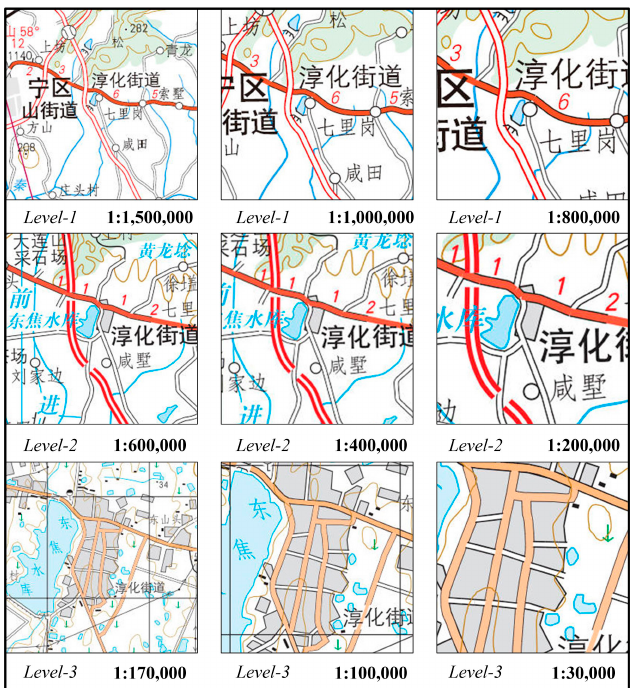
Figure 15. Multi-level PDF tile adaptive zooming. All ratios from “1:1,500,000” to “1:30,000” denote the map display ratio. The corresponding map scale of level-1 PDF tile is 1:1,000,000. The corresponding map scale of level-2 PDF tile is 1:250,000. The corresponding map scale of level-3 PDF tile is 1:50,000.